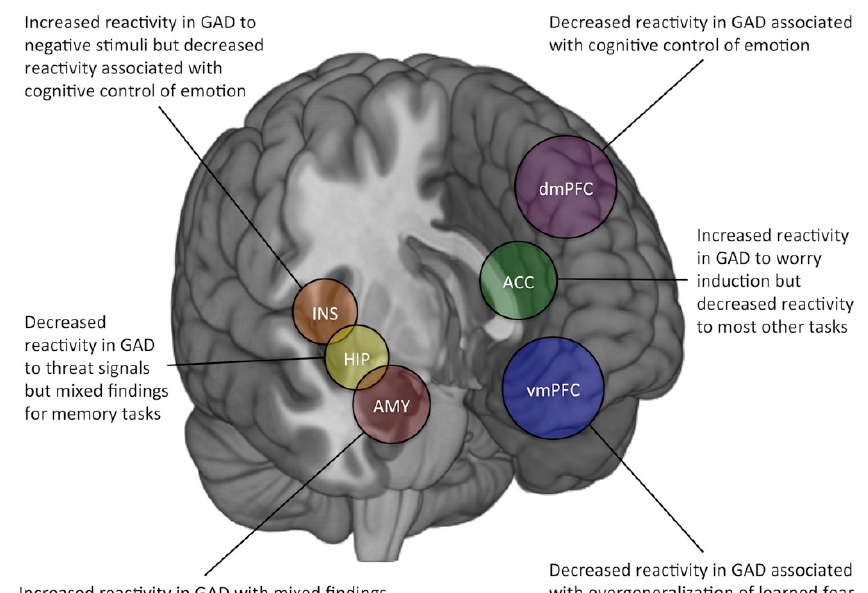
Figure 1. Summary of the findings from task-based fMRI studies of generalized anxiety disorder (GAD), focusing on blood oxygen level-dependent (BOLD) signal changes within the corticolimbic circuit and other brain regions. Overall, the results were largely dependent upon the task used to elicit regional brain activity. ACC: anterior cingulate cortex; AMY: amygdala; dmPFC: dorsomedial prefrontal cortex; HIP: hippocampus; INS: insula; vmPFC: ventromedial prefrontal cortex.